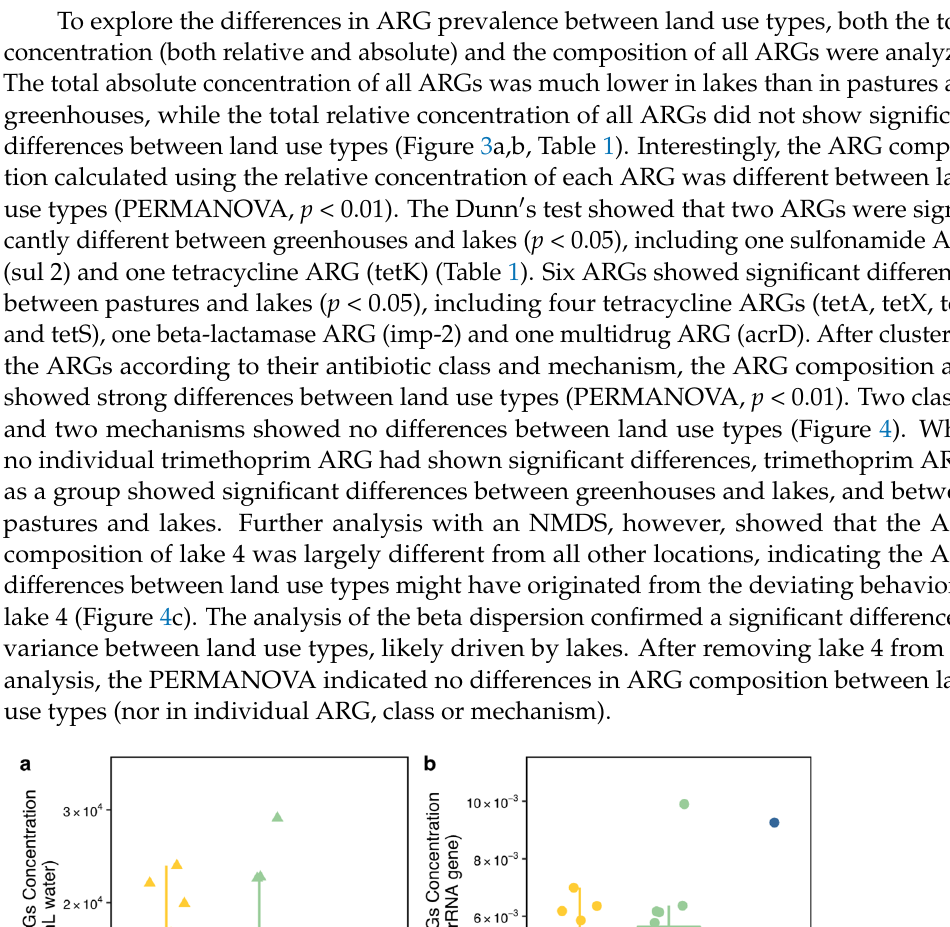
Figure 3. Total absolute ARG concentrations (copies/mL water) ( a ) and total relative ARG concentra- tions (copies/16S rRNA gene copy) ( b ). Colors indicate the location types, including pasture (yellow), greenhouse (green) and lake (blue).